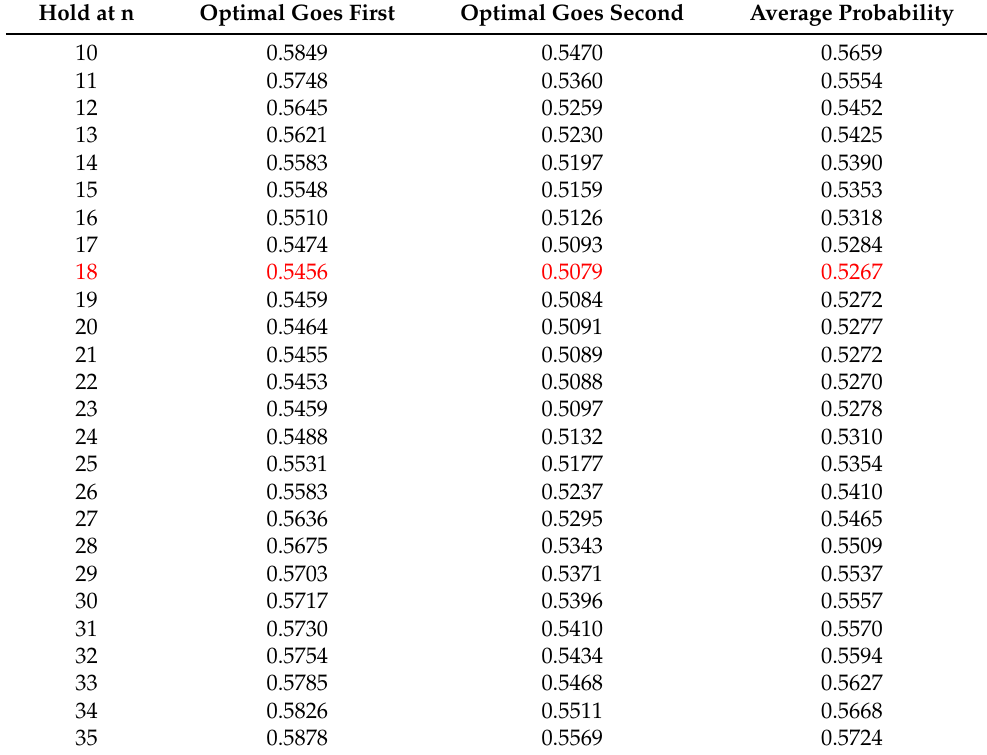
Table A3. Detailed winning probabilities of the optimal strategy against the “hold at n” strategy, for “Double Trouble”, a variation of the standard two-dice Pig game. Here the “hold at 18” is the best choice with the average winning chance against the optimal strategy being 0.4733 (= 1 − 0.5267). Hold at